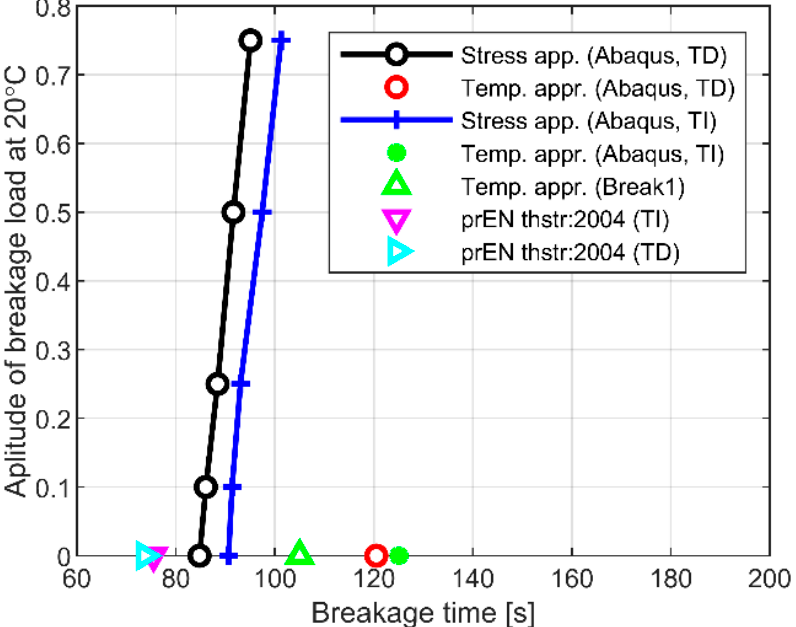
Figure 17. Comparison of different approaches for determination of breakage time of 5 mm pane made of annealed float glass exposed to ISO 834 ‐ 1 fire.